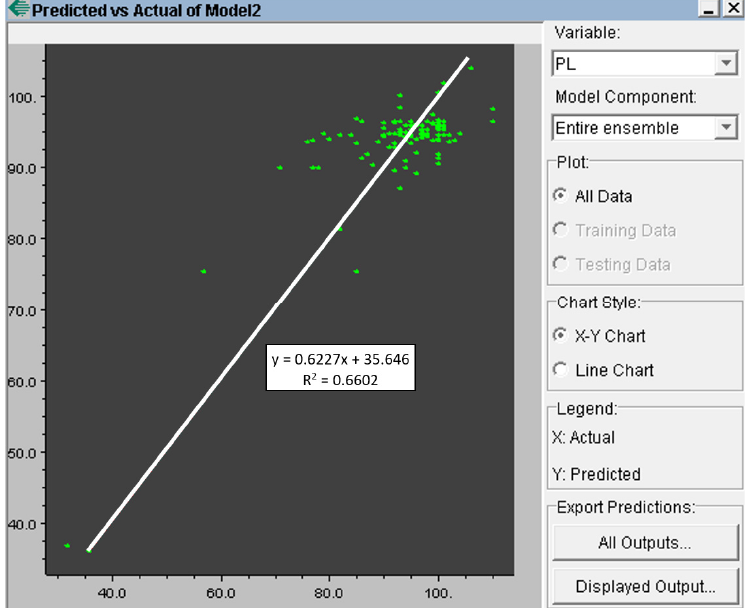
Figure 13. Correlation between calculated (y-axis) and actual (x-axis) ladle lining life.